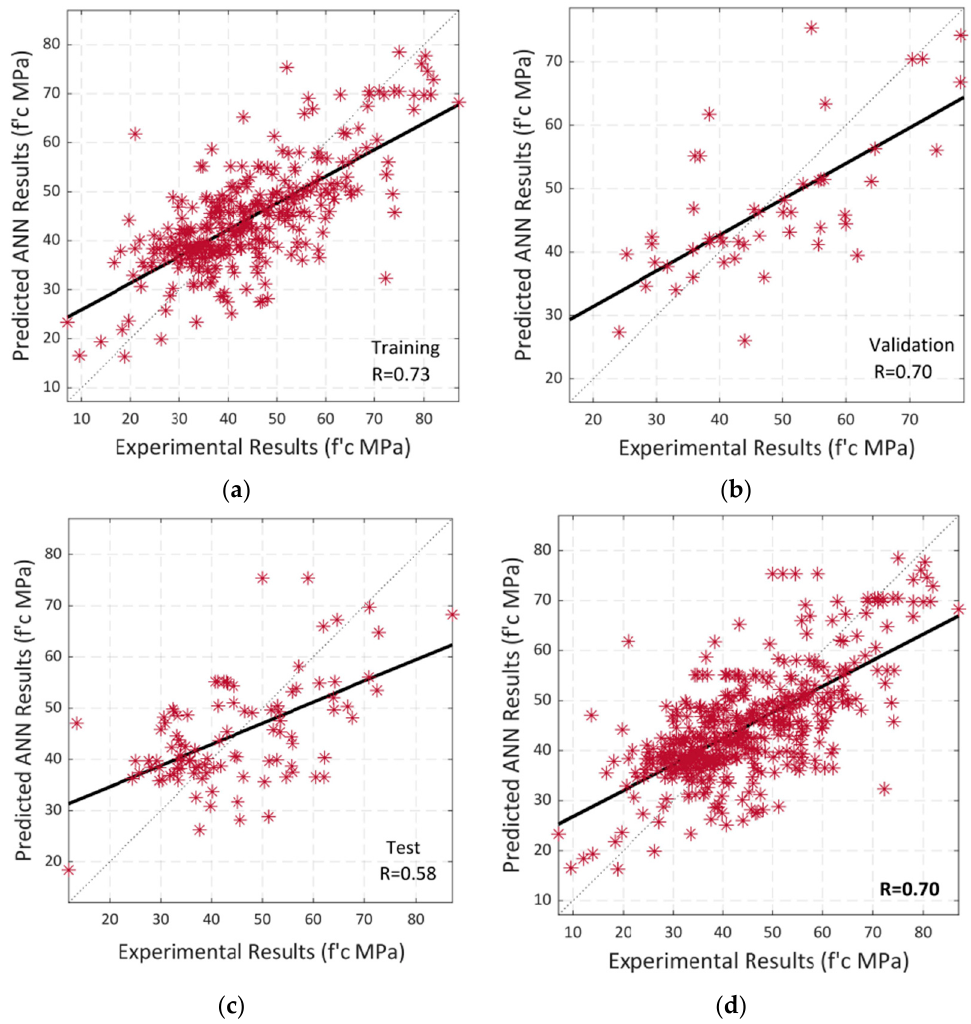
Figure 19. Regression analysis by using SCG algorithm between experimental and predicted com- pressive strength: ( a ) Training; ( b ) Validation; (c) Testing; ( d ) Overall Dataset. Table 6. Summary of SCGB algorithm model assessment